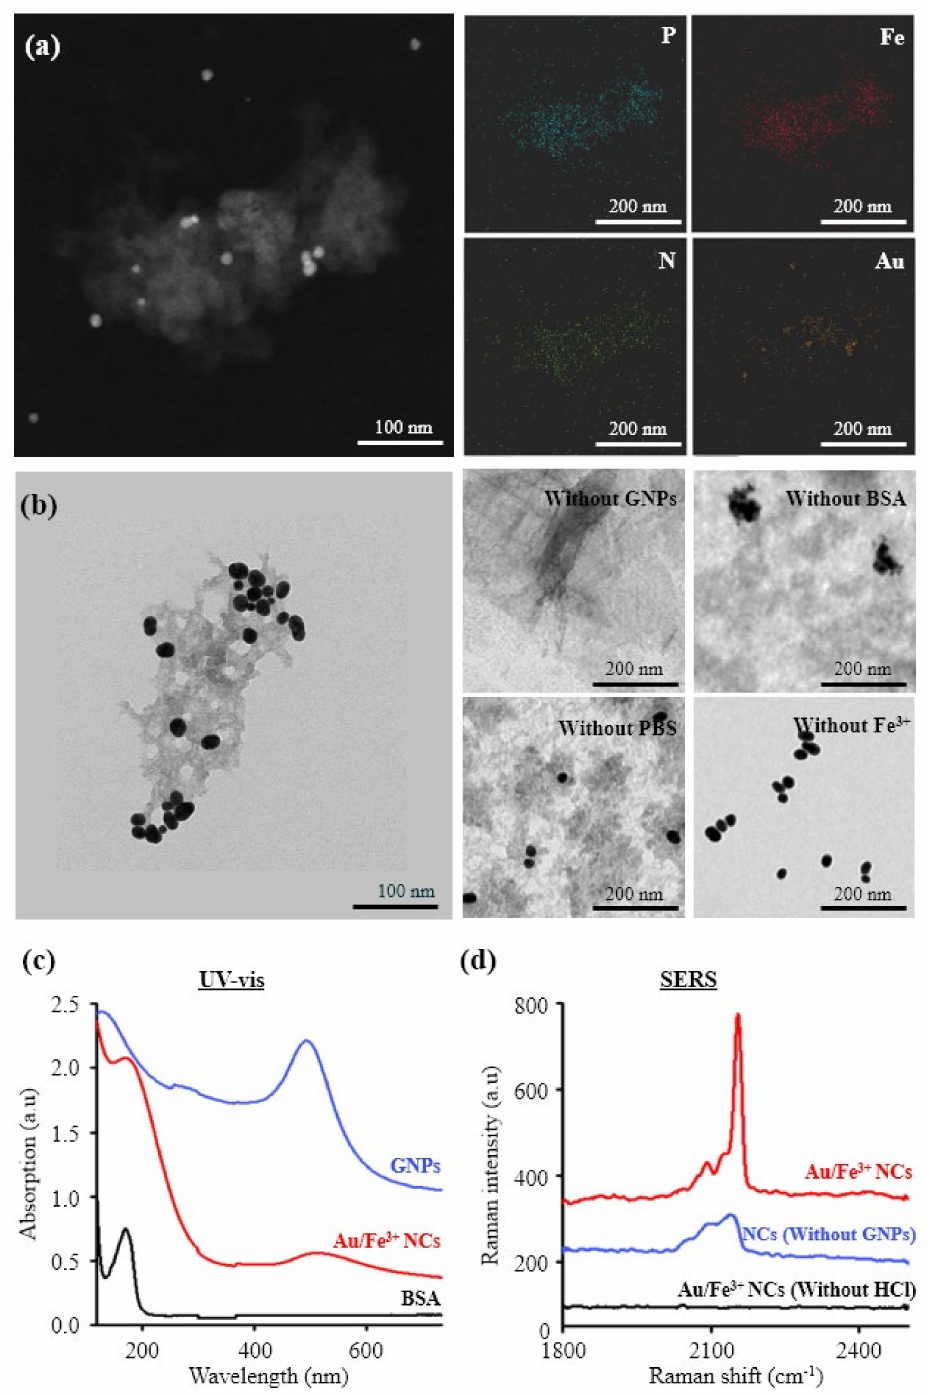
Figure 2. Characterization of Au/Fe 3+ NCs. ( a ) HRTEM images and energy dispersive spectrometry images of Au/Fe 3+ NCs; P = PBS, Fe = FeCl 3 , N = BSA and antibody, Au = gold nanoparticle. ( b ) TEM images of Au/Fe 3+ NCs and synthesized products with one reagent missing. ( c ) Ultraviolet absorption spectra of Au nanoparticles, BSA, and Au/Fe 3+ NCs. ( d ) Raman enhancement by Au/Fe 3+ NCs after metathesis